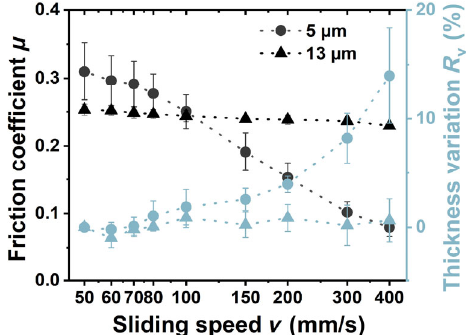
Fig. 3 Friction coefficient and relative variation in film thickness R v of frictional surfaces as a function of sliding